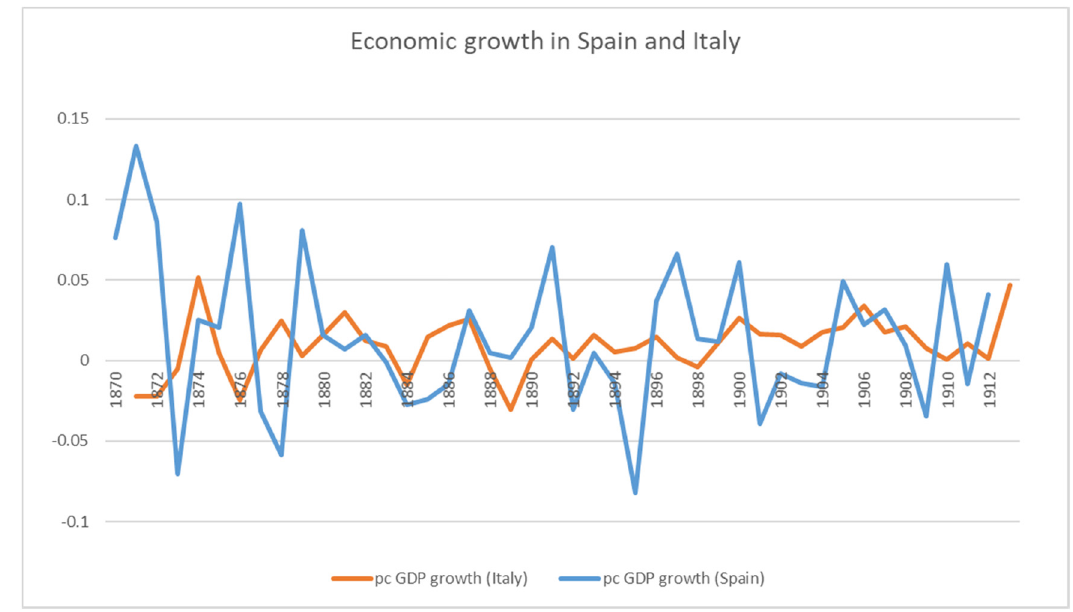
Figure 1: Economic growth in Spain and Italy. Source: Prados de la Escosura ( 2003 ) for Spain and Ba ffi gi ( 2013 ) for Italy.